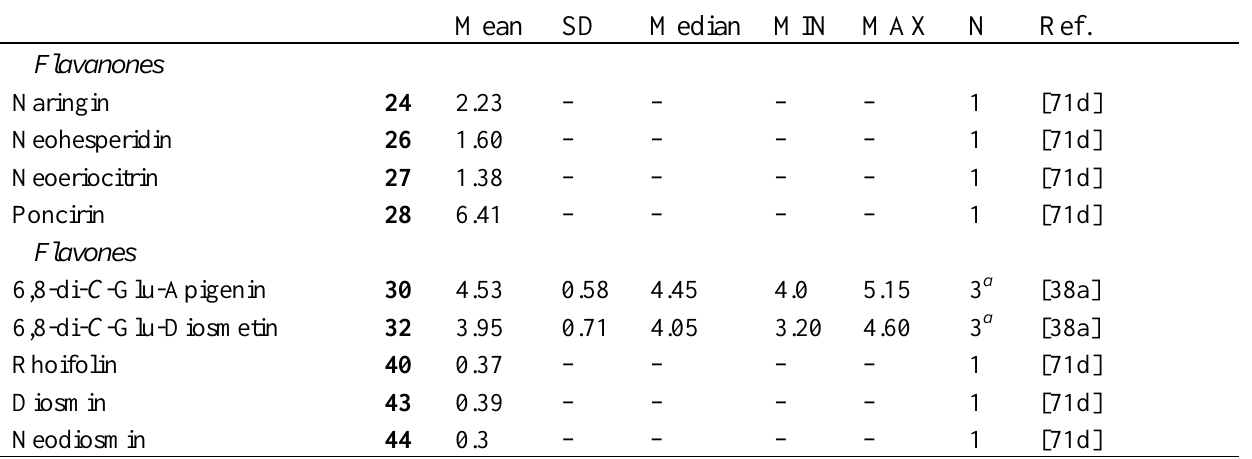
Table 15 . Flavonoid composition of C. bergamia juice (mg/100